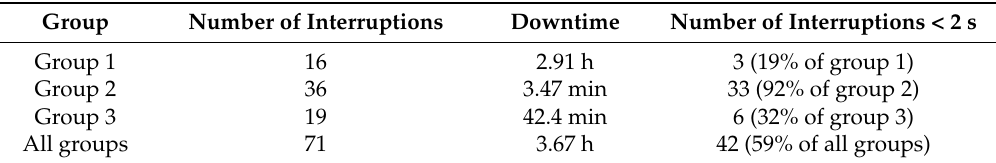
Table 3. Interruptions and downtime for the different groups.